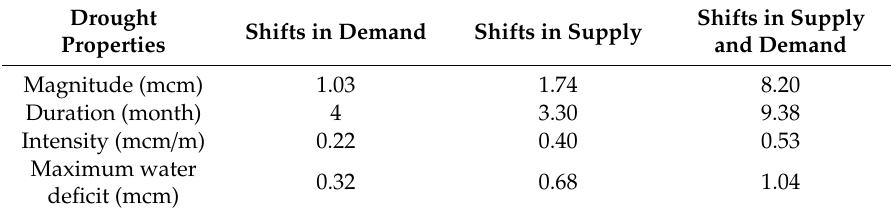
Table 2. Impacts of shifts in both water supply and water demand on drought properties.